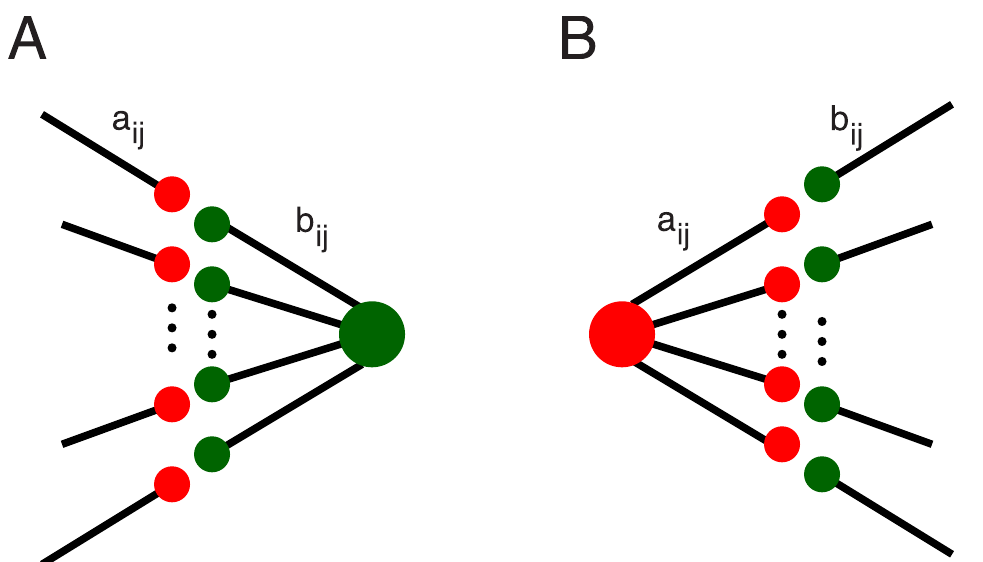
Fig 11. Illustration of synaptic competition induced by hetero-synaptic plasticity. (A) Competition induced by post-synaptic hetero-synaptic plasticity. Excitatory pre-synaptic neurons i target a post-synaptic neuron j. We assume that the resources required for increasing the post-synaptic components b ij of the weights w ji = a ij b ij are limited and therefore distributed in a competitive manner. That is, we assume hetero-synaptic plasticity where afferent synapses that receive large eligibility signals ε increase their efficacy while synapses that receive weaker (but for excitatory ij synapses always positive) signals will instead weaken. (B) Pre-synaptically induced competition is assumed to follow the same principle. The signals for the changes of the pre-synaptic components a , however, are assumed to depend on the ij realized amount of potentiation at the post-synaptic side, i.e., to take the post-synaptic hetero-synaptic competition into account. We found that this choice is more parameter tolerant and yields more robust memory than a symmetric version where pre- and post-synaptic hetero-synaptic plasticity are based on the same eligibility signal which, however, can also realize self-organized spike pattern detection (not